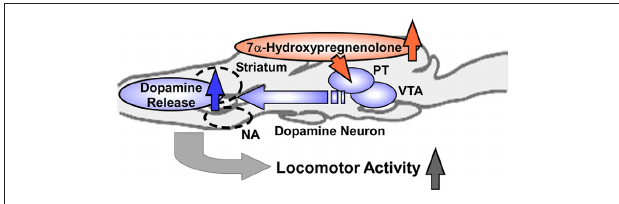
FigurE 4 | Schematic model depicting the possible action of 7 α -hydroxypregnenolone on the regulation of locomotor activity in male newt. 7 α -Hydroxypregnenolone synthesized actively in the diencephalon and rhombencephalon, by acting on dopaminergic neurons localized in the posterior tuberal (PT) nucleus and ventral tegmental area (VTA), may induce dopamine release from their terminals in rostral brain regions, notably in the striatum and nucleus accumbens (NA), and consequently increase locomotor activity of male newt. See the text for